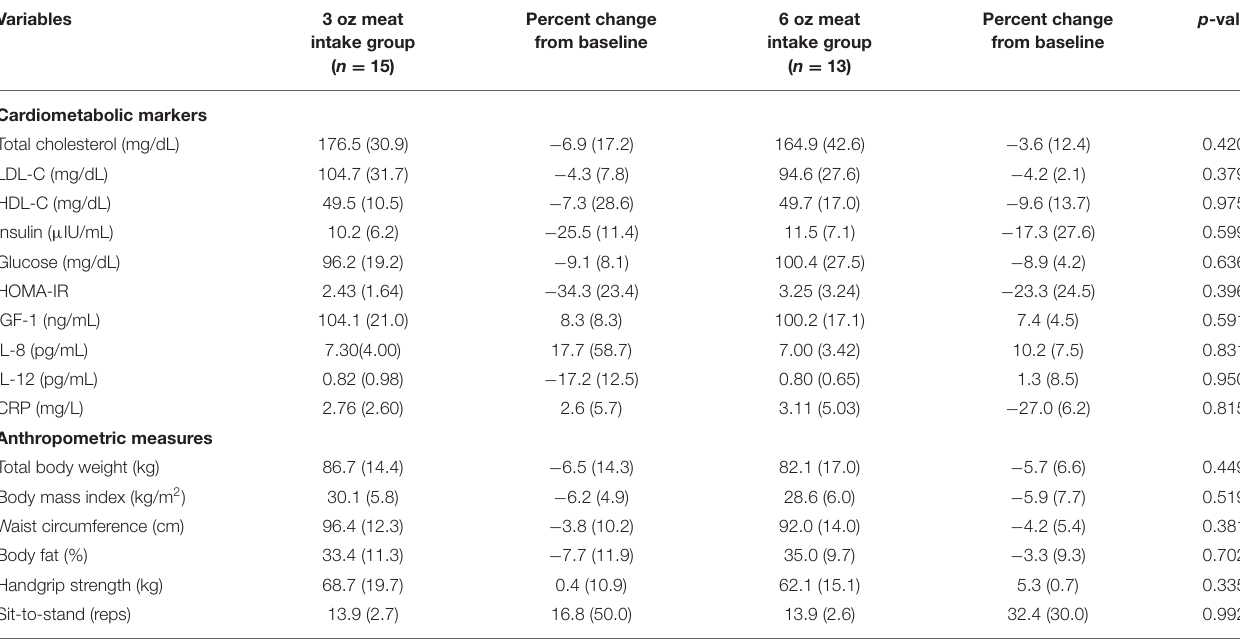
TABLE 3 | Cardiometabolic and body composition characteristics of obese older adults at week 12. Variables